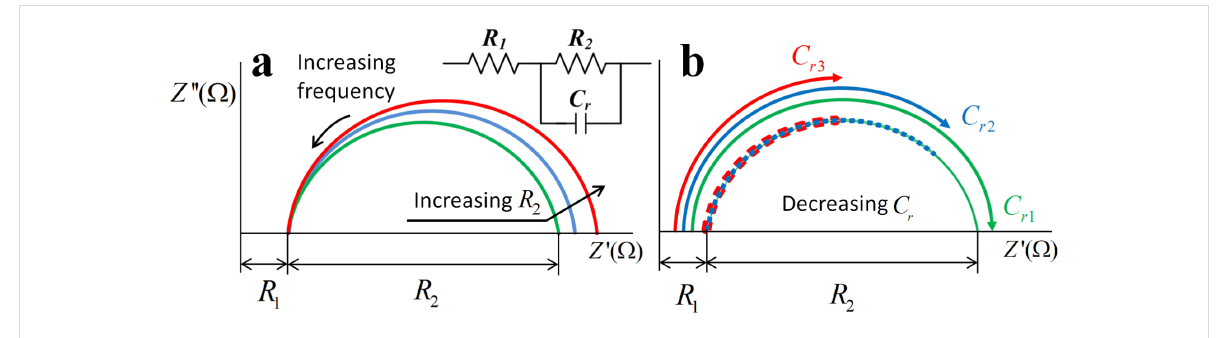
Figure 2: Sketch of frequency (a), resistance (a) and capacity (b, where C r 1 < C r 2 < C r 3 ) variations in the Cole–Cole plot of the proposed